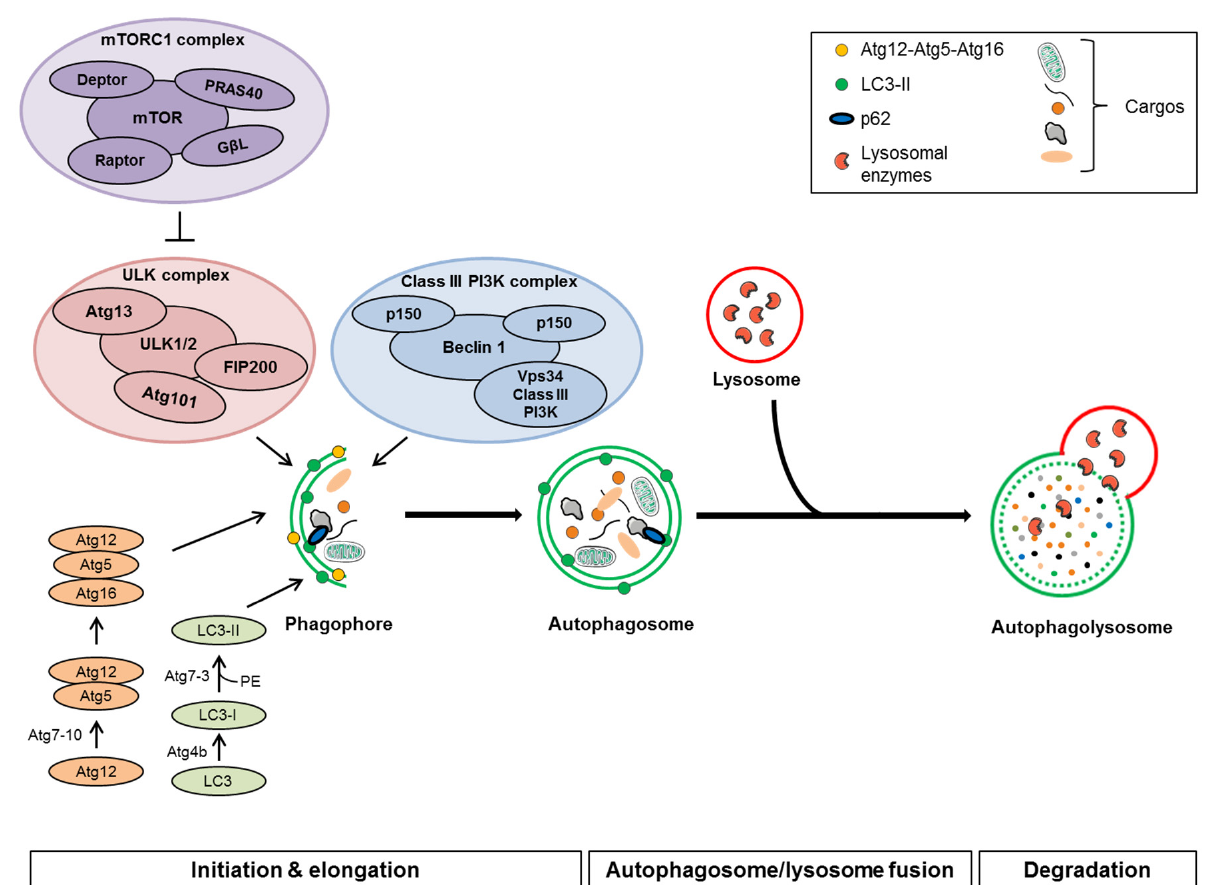
Figure 1. Scheme of the autophagic